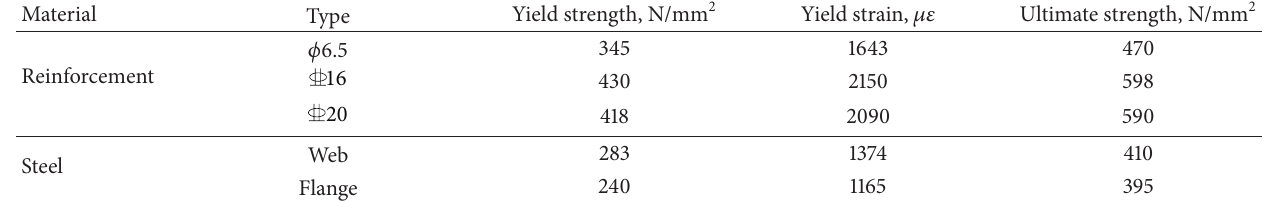
Table 3: Material